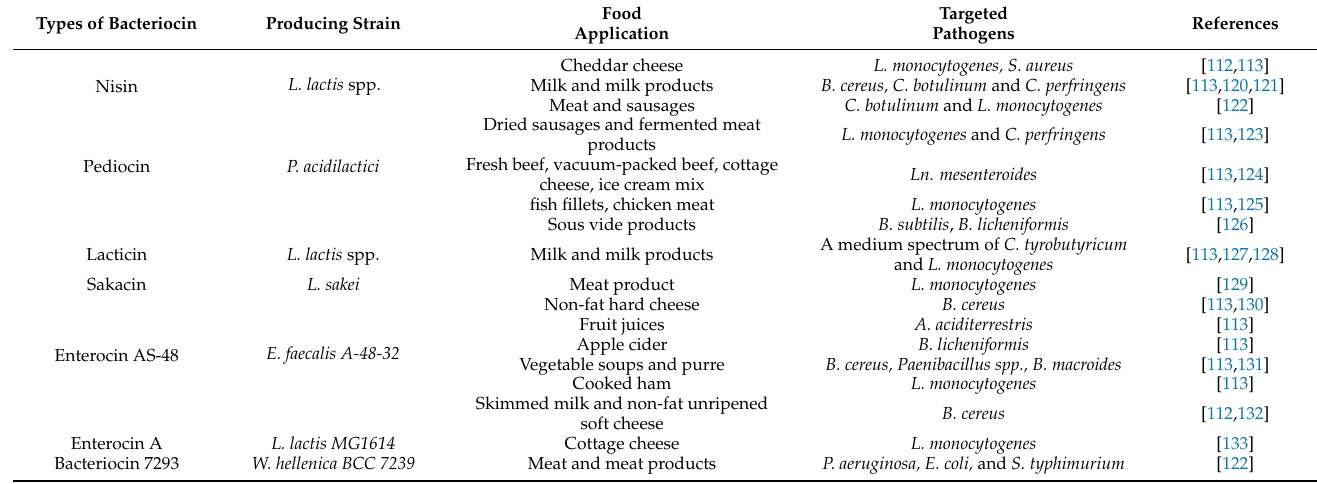
Table 2. Application of bacteriocin from LAB in food